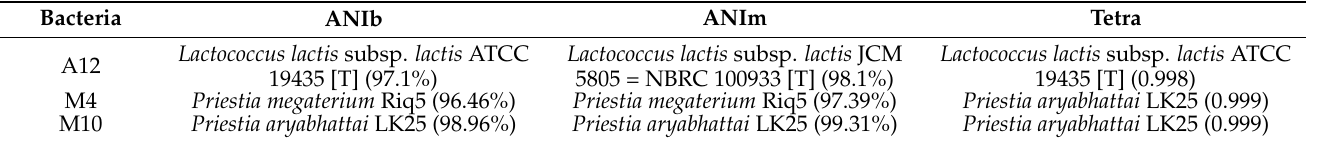
Table 1. Determination of the overall genome relatedness indices (ANIm, ANIb, Tetra) of the bacteria A12, M4, and